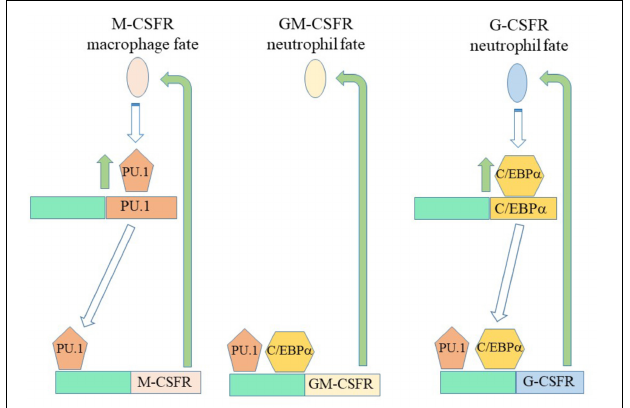
FIGURE 4 | Auto and promiscuous regulation of the expression of cytokin receptors. Macrophage-colony stimulating factor and granulocyte/ macrophage-colony stimulating factor/granulocyte-colony stimulating factor can instruct macrophage and neutrophil fates, respectively. Macrophage-colony stimulating factor receptor (M-CSFR) instruction of HSCs leads to expression of the transcription factor PU.1. PU.1 in turn regulates expression of the M-CSFR, the granulocyte/macrophage-colony stimulating factor receptor (GM-CSFR) and the granulocyte-colony stimulating factor receptor (G-CSFR). G-CSF receptor signaling increases the expression of C/EBP α that regulates the expression of the GM-CSFR and the G-CSFR. A complex interplay between transcription factors and the expression of cytokine receptors might underlie meta-stable bi-lineage cell states and allow HSCs that express the M-CSFR and cytokine stimulated to co-express G-CSFR “side step” to an adjacent pathway ( Figure 1 ).